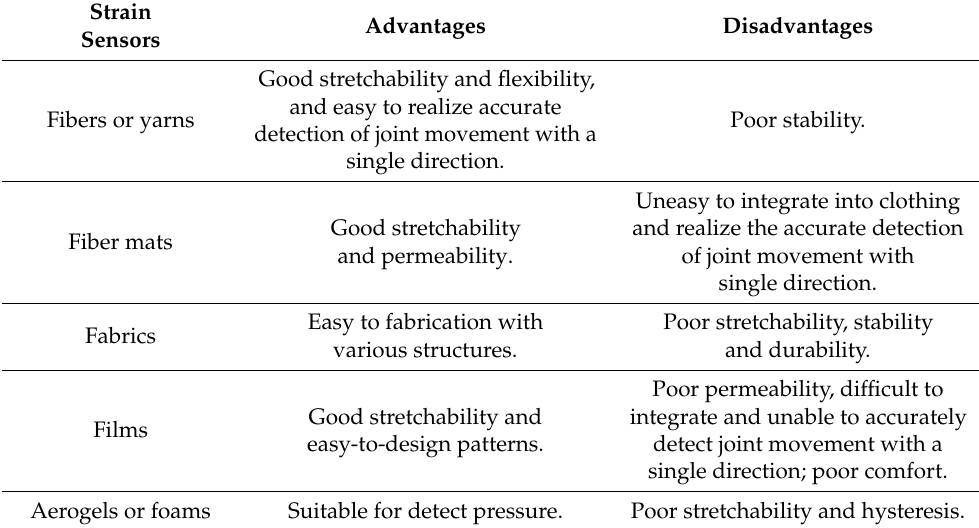
Table 1. Features of flexible strain sensors with different